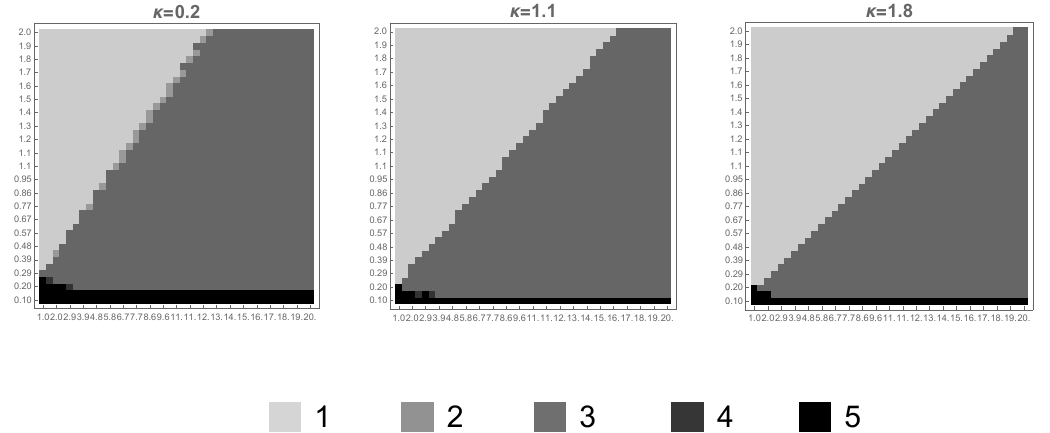
Figure 14 . The number of independent black hole solutions in the ( γ, τ ) parameter space for b = 1 , and three values of the tension ( κ = 0 . 2; 1 . 1; and 1 . 8) . The darker the shade the larger the number of black